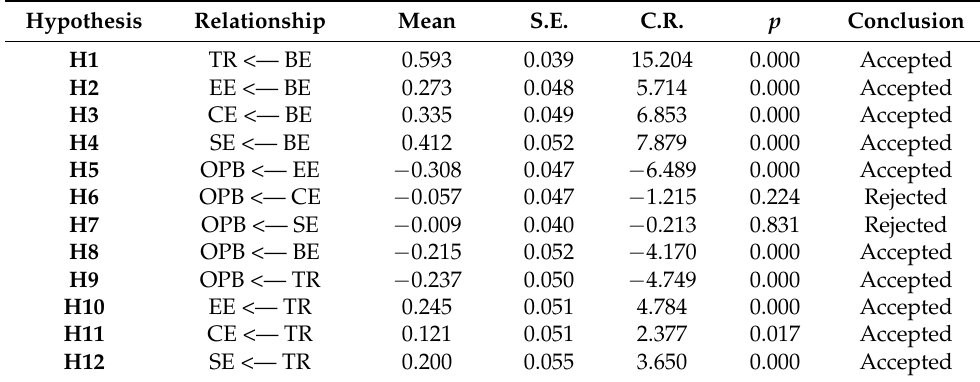
Table 4. SEM analysis results for the relationships in the model. Hypothesis Relationship